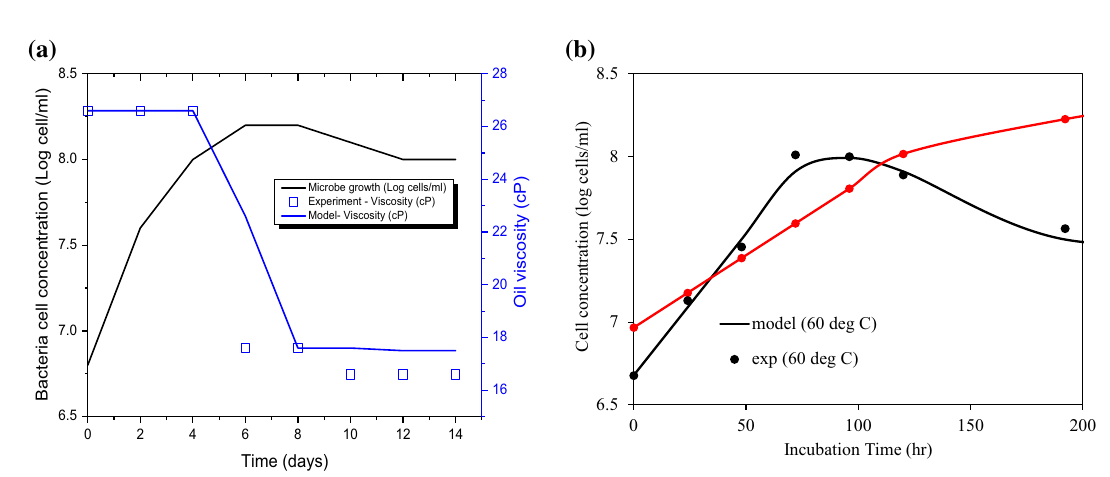
Fig. 3 History matching for a oil viscosity reduction and microbe growth rate and b microbe growth rate per temperature